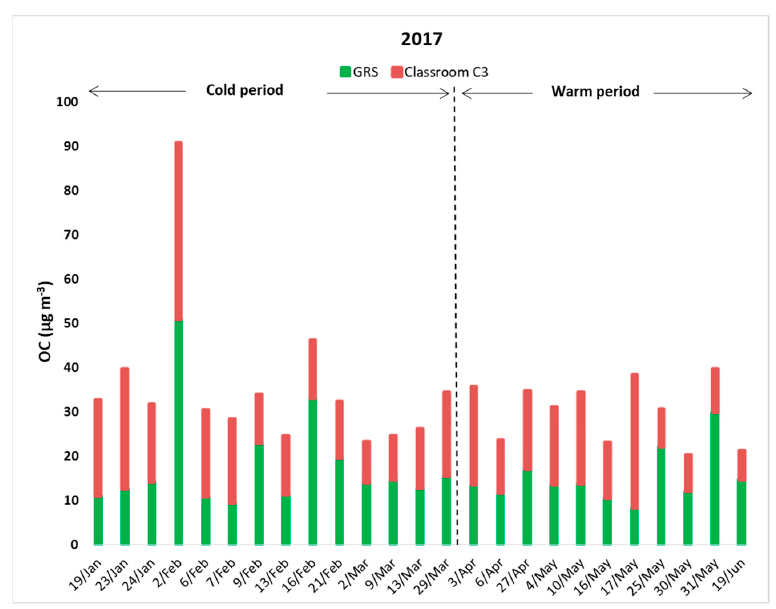
Figure 3. Indoor and outdoor OC concentrations for all sampling days.